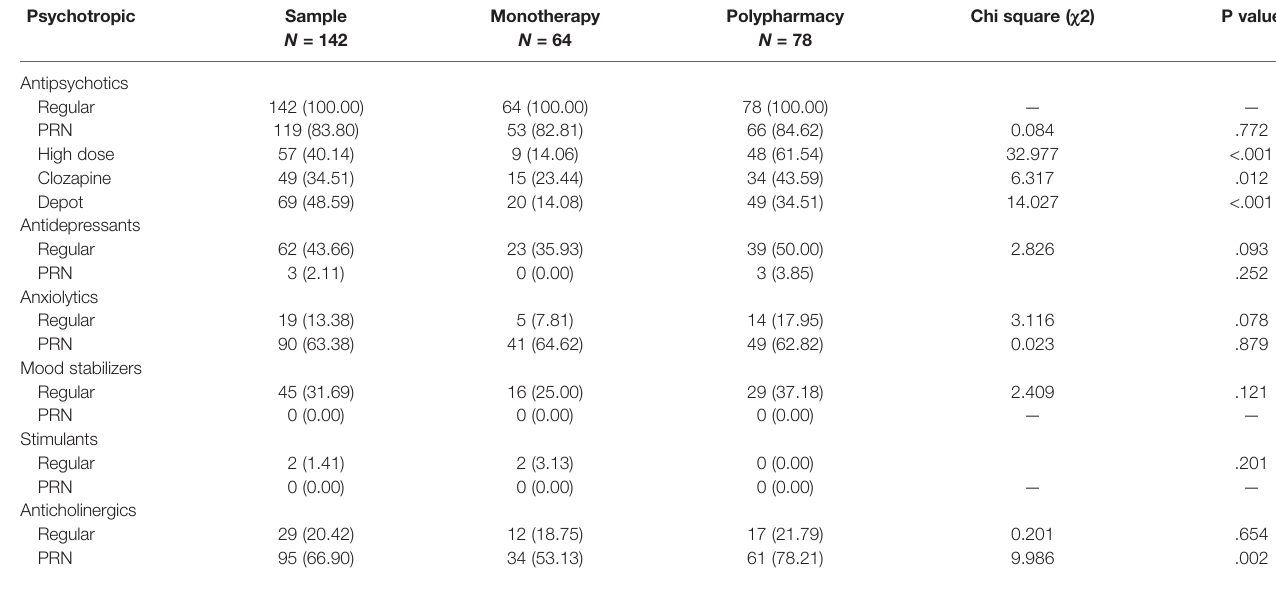
TABLE 2 | Frequencies of psychotropics prescribed and associations between types of psychotropics prescribed and exposure to antipsychotic polypharmacy.